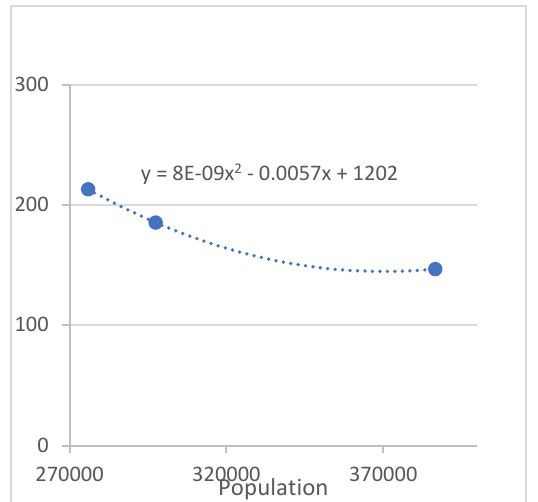
Figure 11. Wetland and Population Change The projection function contained in Figure 11 indicates a wetland cover (y) for any given population (x) within the study